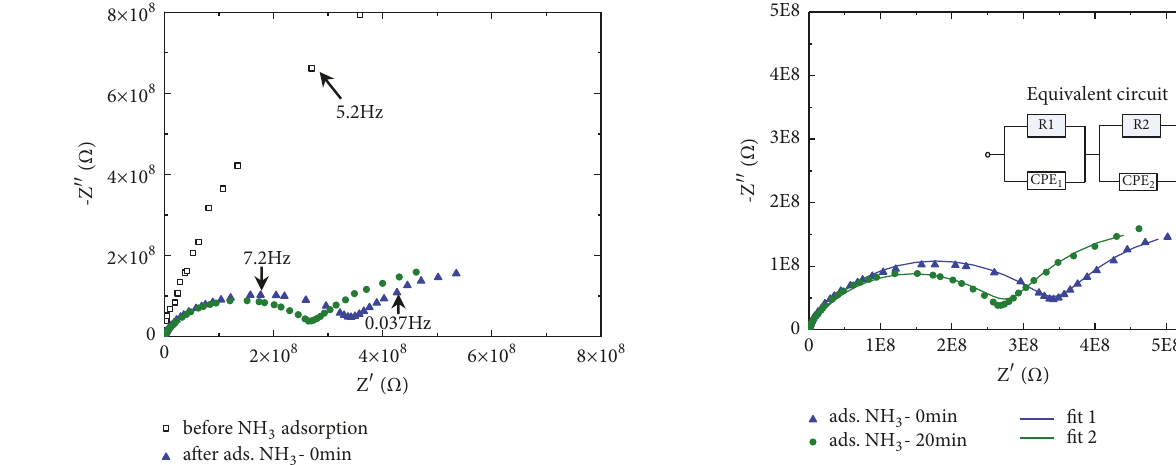
Figure 3: Fit of experimental data by the equivalent circuit with respect to Figure